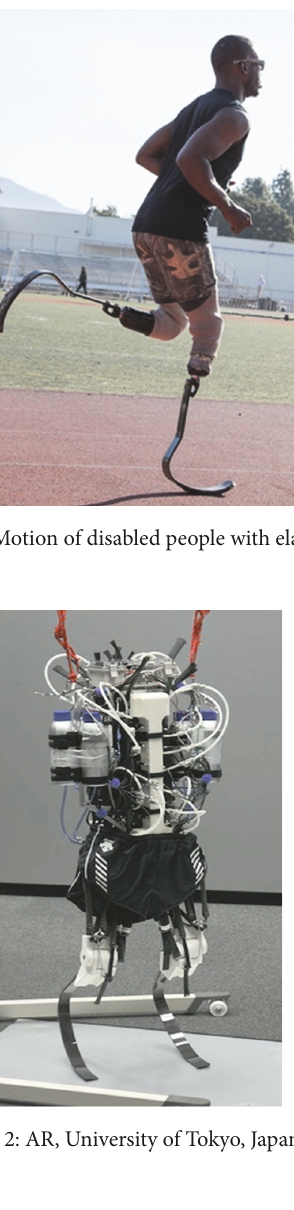
Figure 2: AR, University of Tokyo, Japan [14].